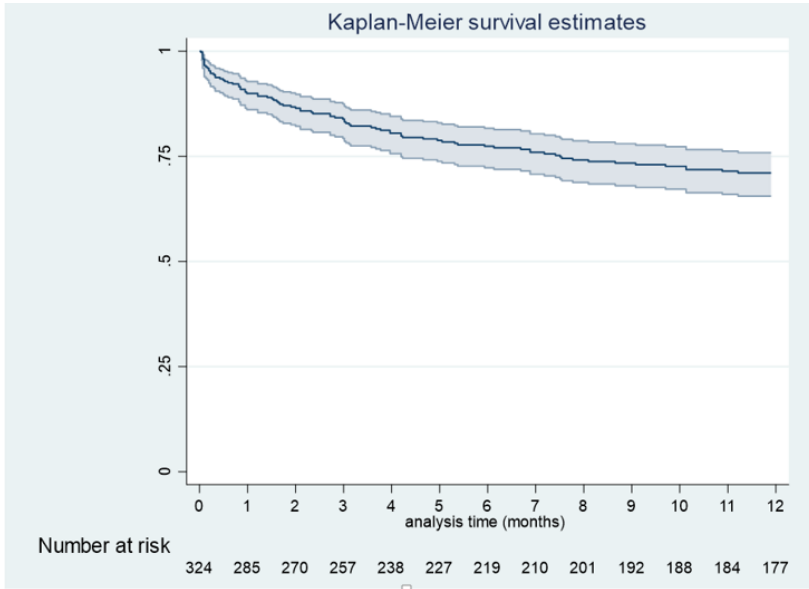
Figure 1. Survival curves for the first 12 months for HIV-associated disseminated histoplasmosis in French Guiana.